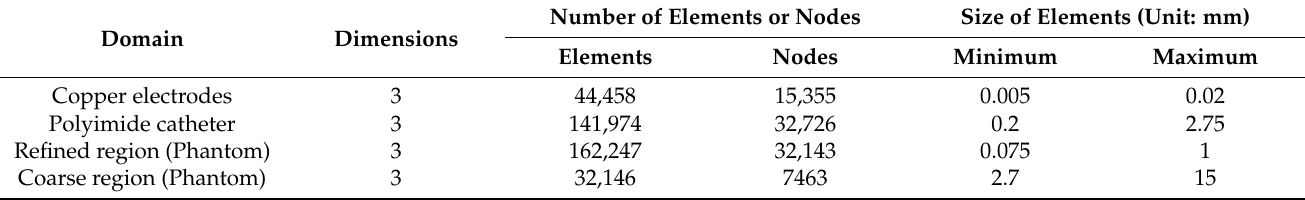
Table A1. Mesh information for the model.